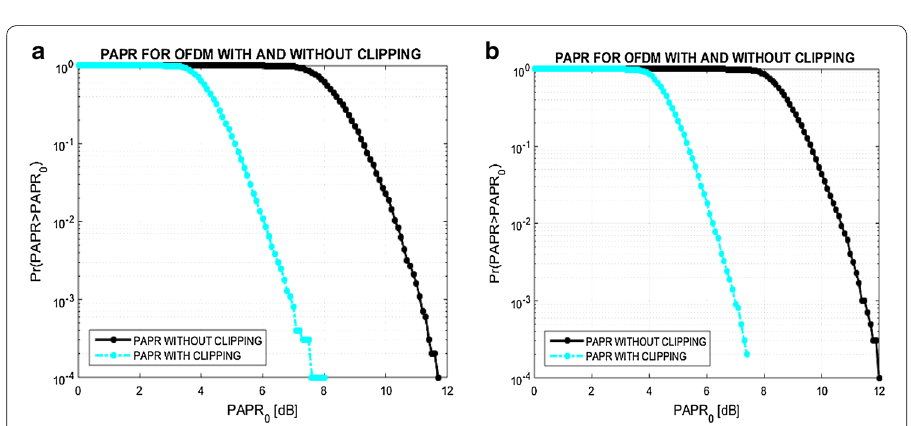
Fig. 2 a The number of subcarriers